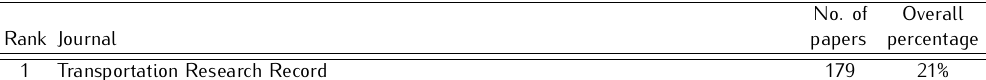
Table 2. Top three journals and proceedings with respect to DTA-related papers Table 2a. Journals